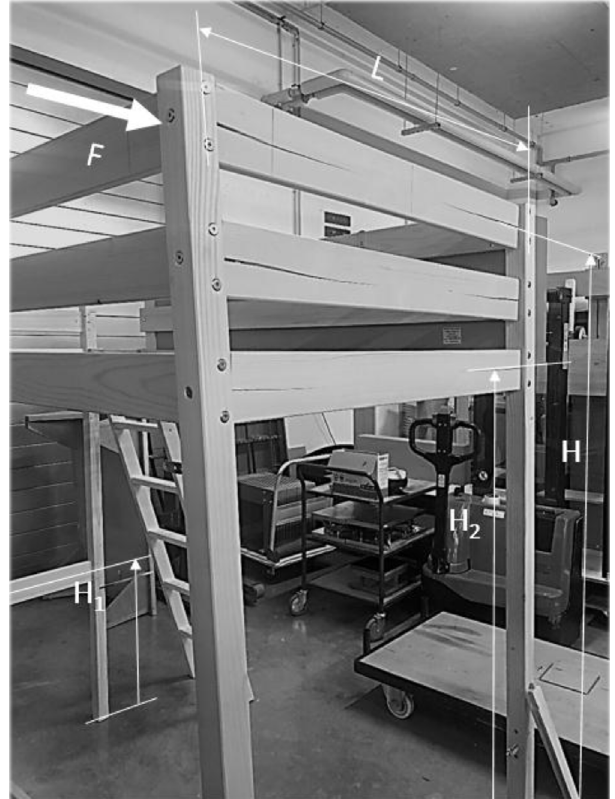
Fig. 10. High loft bed after testing at FCBA: the three upper bed rails show horizontal crack propagation, while the fourth lower rail is completely broken and is laying on the side of the right bed post. All the geometric dimensions in the vertical direction (namely the heights H, H 1 and H 2 ) are measured from the fl oor.